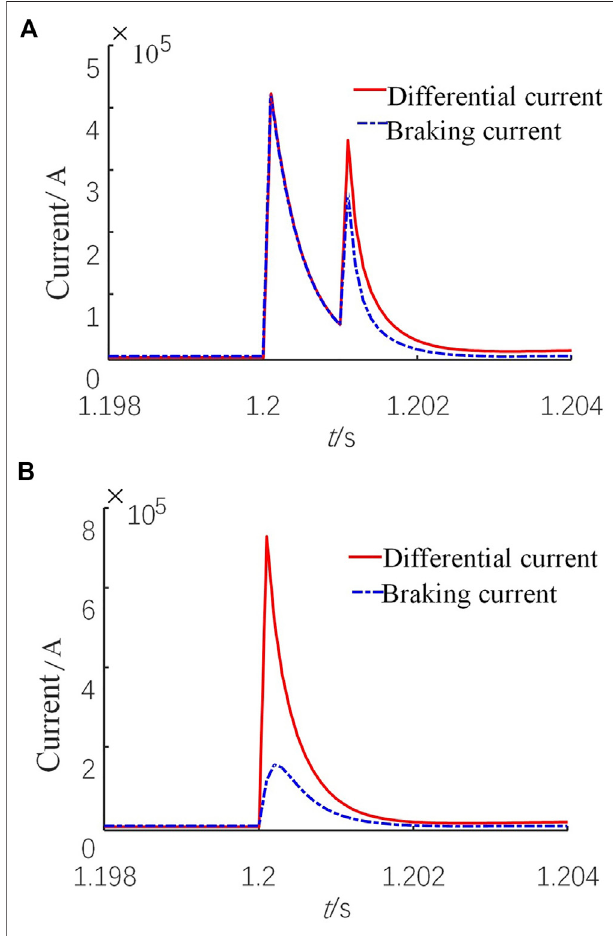
FIGURE9| Differentialcurrentandrestraintcurrentwaveformsunderan internal fault condition (A) Without data synchronization (B) With data